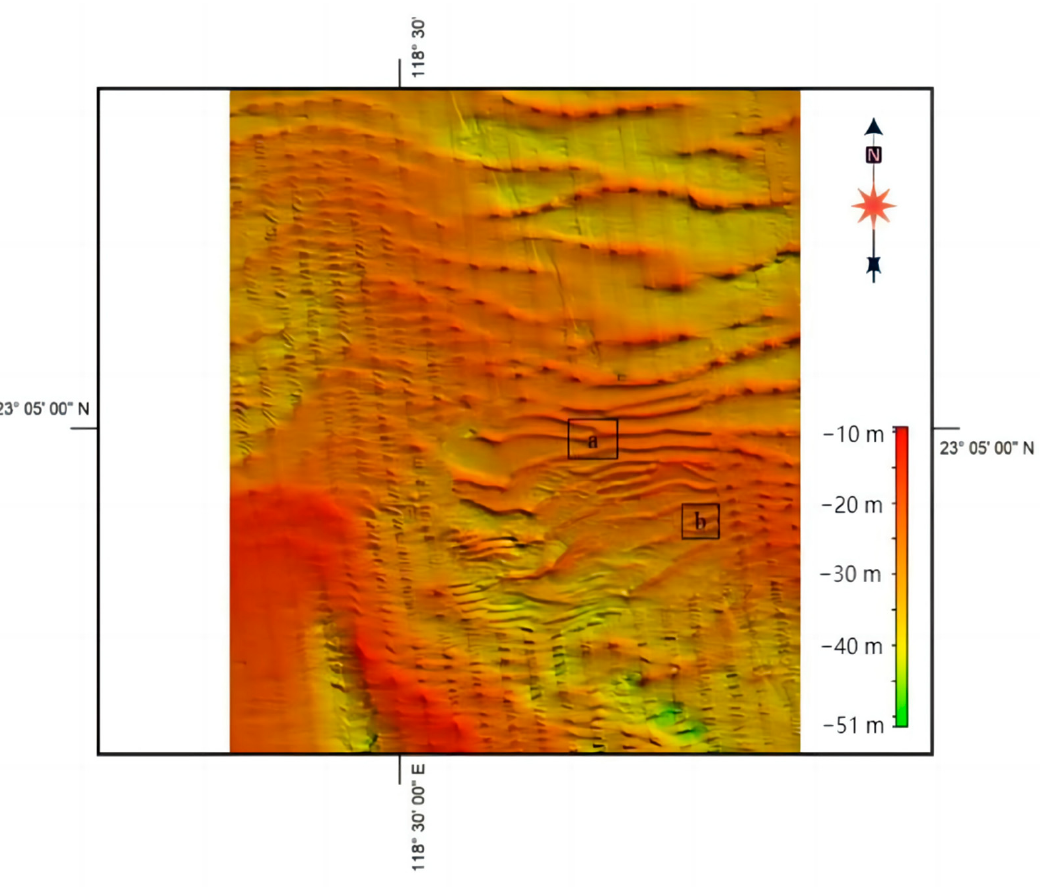
Figure 5. The 2012 bathymetric inversion map. a and b are the location of the interception area.